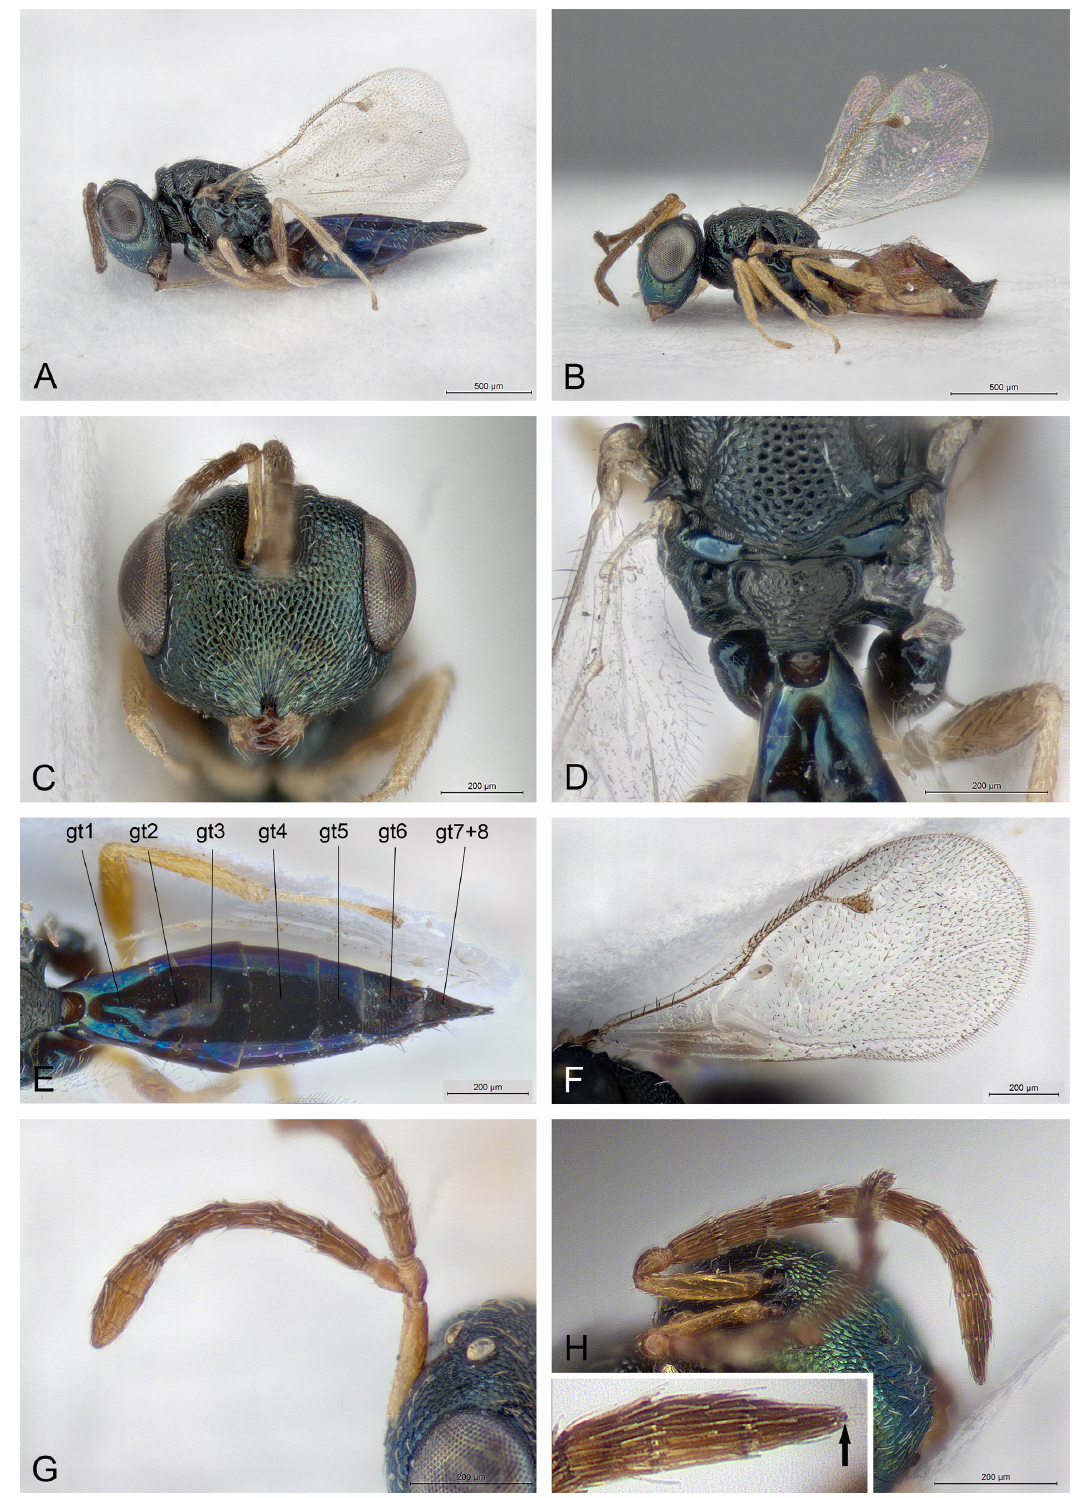
Fig. 3. Habritella noyesi sp. nov. A . Holotype, ♀ (NHMUK). B, H . Allotype, ♂ (NHMUK). C–G . Paratype, ♀ (NHMUK). A . Habitus in lateral view. B . Habitus in lateral view. C . Head in frontal view. D . Detail of mesosoma in dorsal view. E . Metasoma in dorsal view. F . Fore wing in dorsal view. G . Antenna in lateral view. H . Antenna in lateral view (inset: detail of clava indicating the terminal